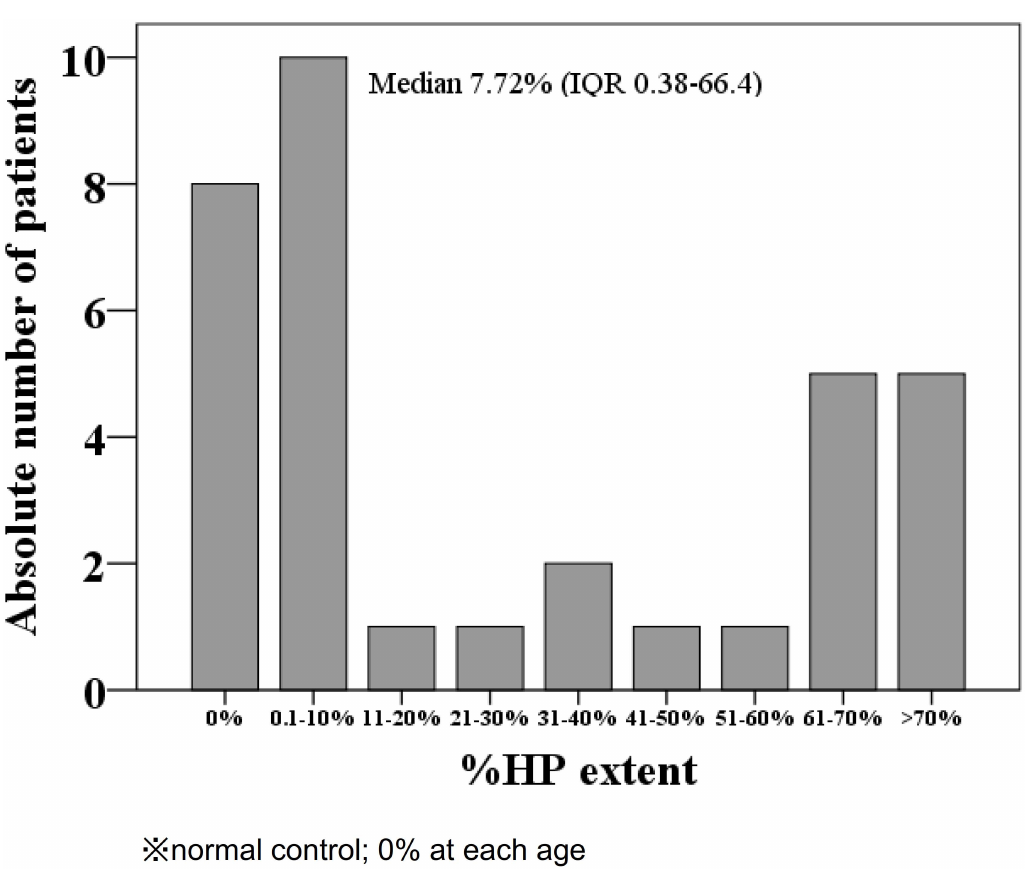
Fig 3. Distribution of % HP extent. %HP extent showedU-shapeddistribution.